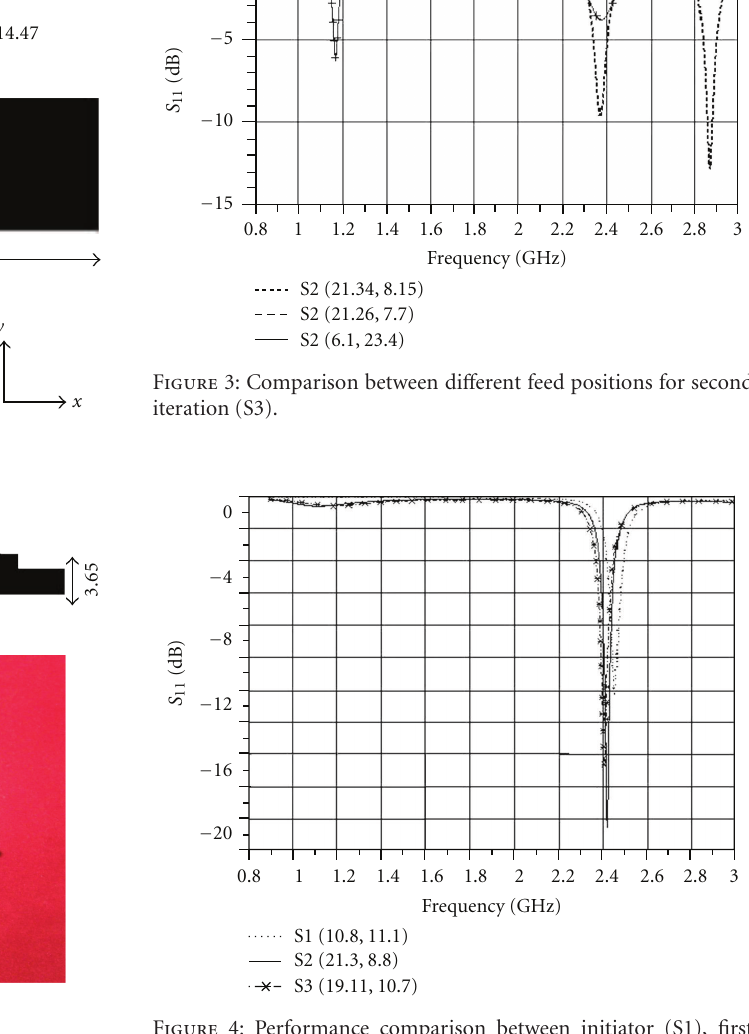
Figure 2: (a) Initiator (S1), (b) first iteration (S2), (c) second iteration (S3), (d) third iteration (S4), (e) prototype of the planar antenna (all dimensions are in mm).